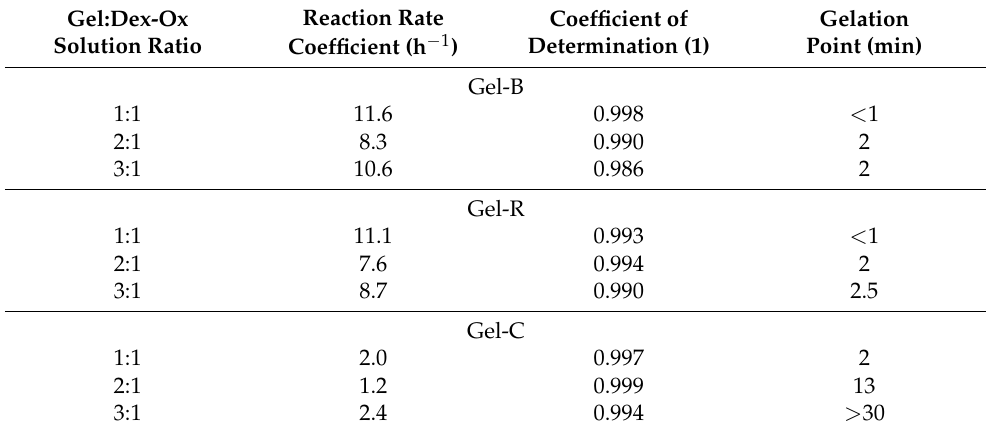
Table 1. Dependence of reaction rate coefficient on reaction mixture